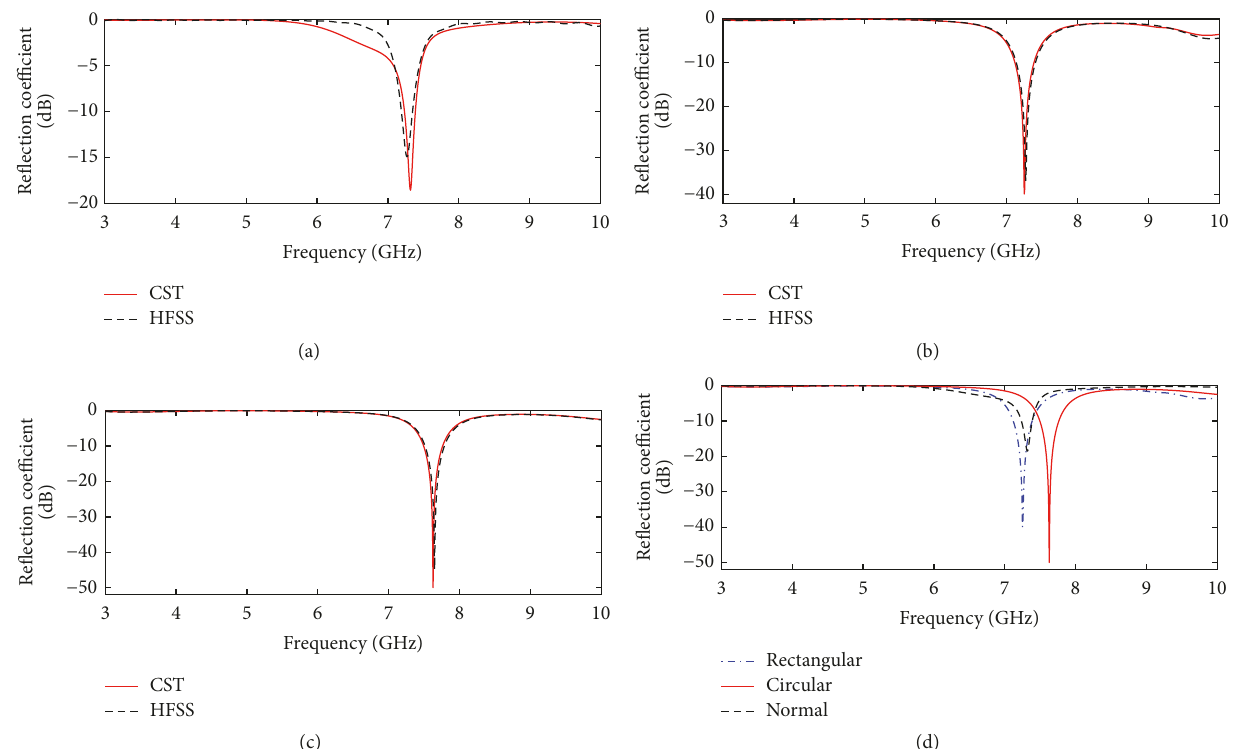
Figure 8: Reflection coefficients of the patch antenna (a) without EBG, (b) with rectangular EBG, (c) and with circular EBG and (d) comparison between three antennas.